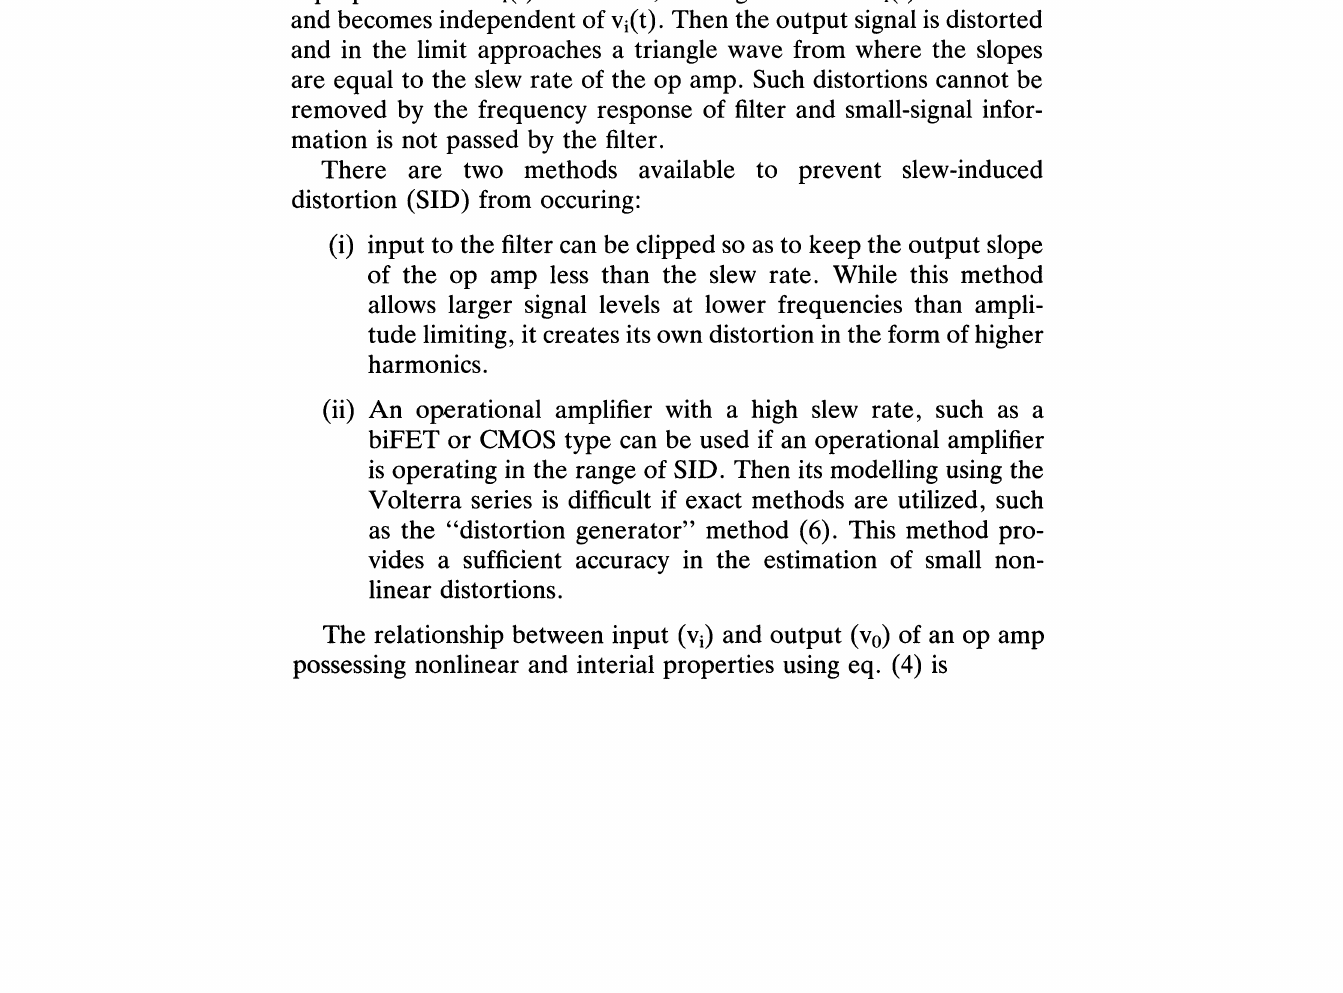
FIGURE 2(a) First-order model of an op